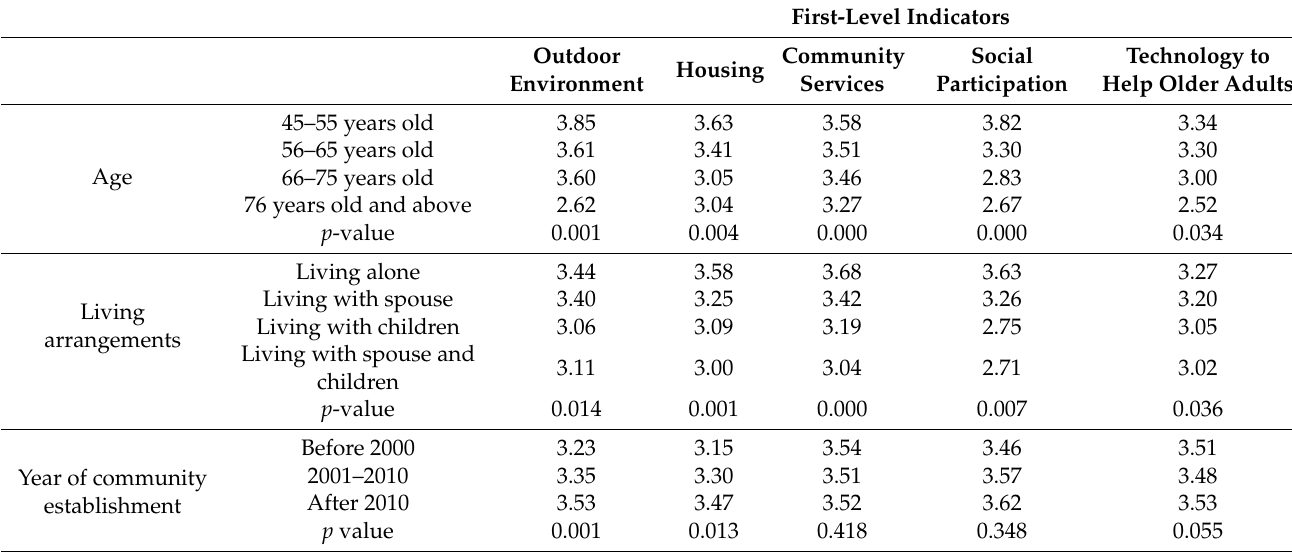
Table 10. Kruskal–Wallis test results for primary